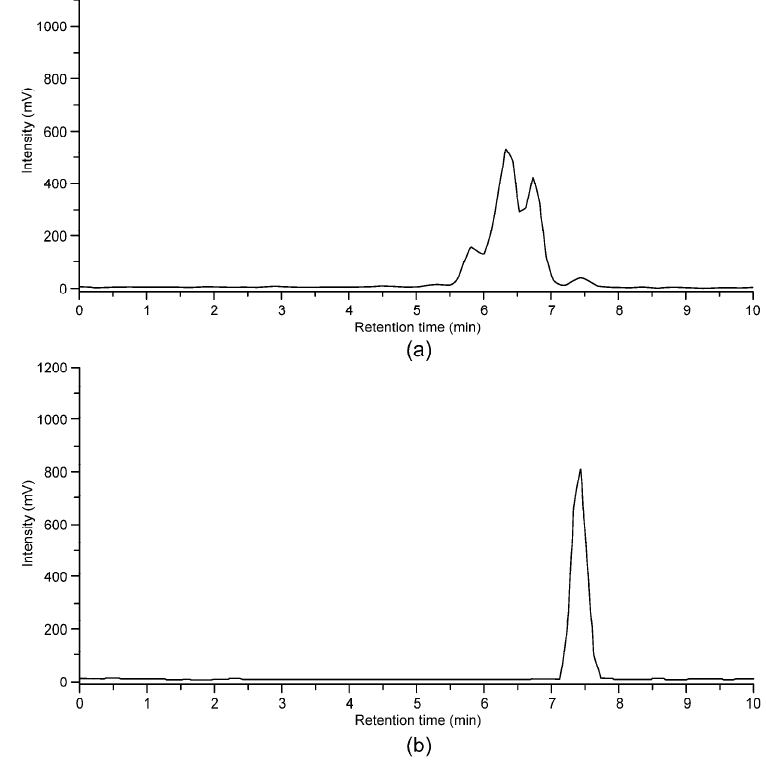
Figure 6. Radiometabolism of [ 18 F]Flutemetamol evaluated with HPLC. ( a ) A chromatogram of C57BL/6N mouse plasma at 30 min post-injection shows several unidentified radioactive metabolites. Only a small fraction of the tracer is intact. ( b ) [ 18 F]Flutemetamol standard.